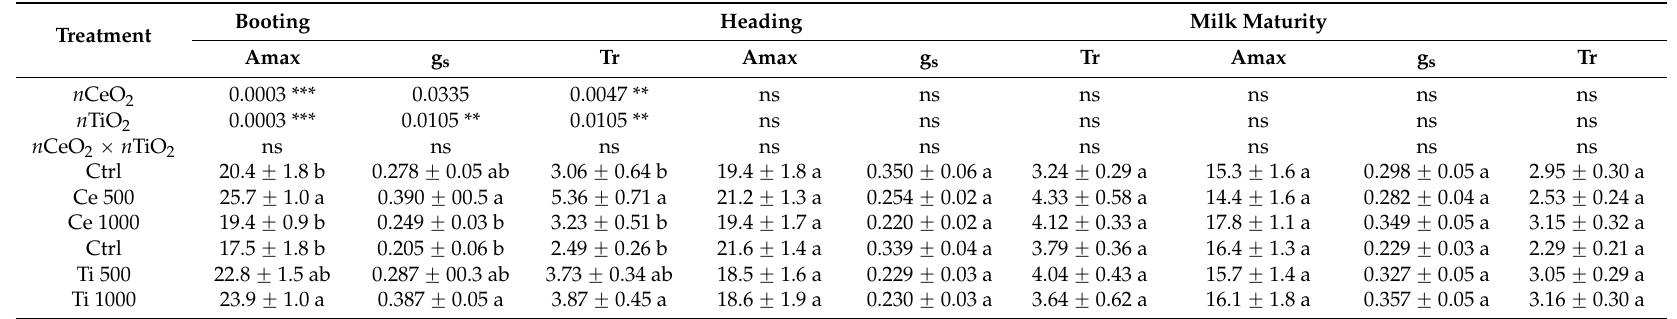
Table 1. ANOVA p value for the main factors ( n CeO 2 , n TiO 2 ) and interaction ( n CeO 2 ˆ n TiO 2 ) for leaf photosynthetic rate at saturating light intensity (Amax, µ mol heading and milk maturity) in leaves of barley growing in control soil and n CeO 2 and n TiO 2 -amended soil. Values are mean ˘ SE ( n = 5). Same letters indicated